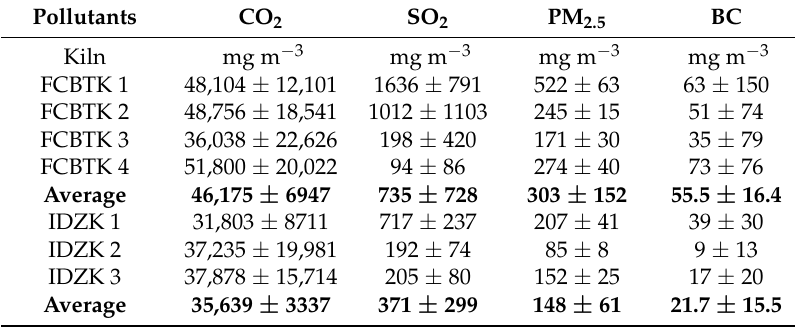
Figure 4. Real-time temporal profile of fuel-based emission factors (g/kg) of gaseous and particulate pollutants at FCBTK1, depicted for four combustion cycles where light green patch denotes non-feeding cycles and white patch denotes feeding cycles. Table 2. Stack gaseous and particulate pollutants concentration at 25 °C and 1 atm pressure.